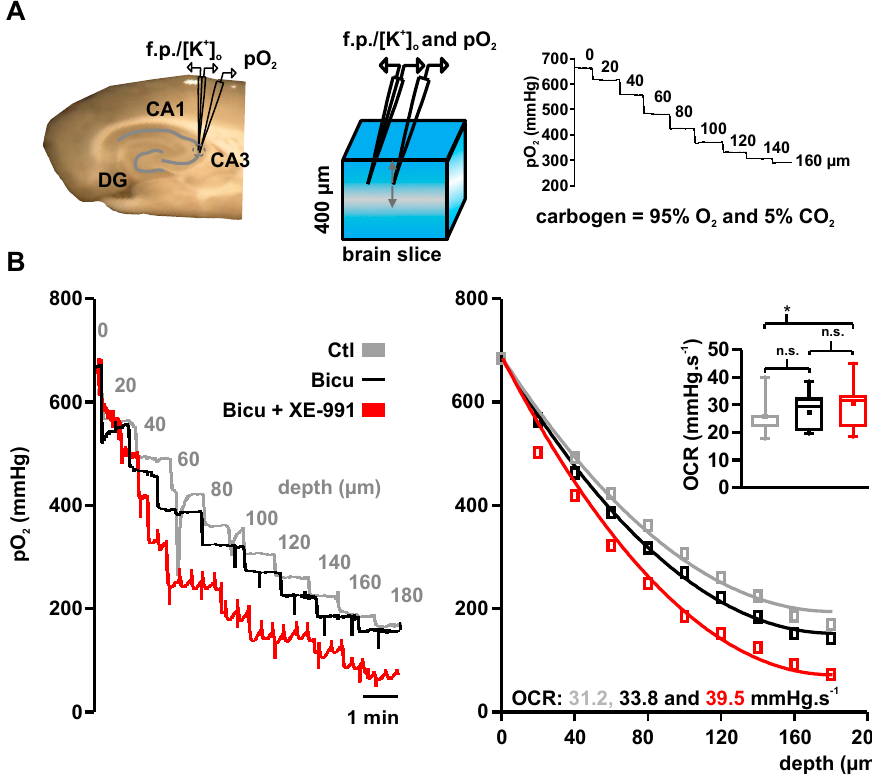
Figure 2. Variations in basal pO 2 under bicuculline and bicuculline + XE-991: ( A ) Left: Picture and scheme of typical electrode placement in acute hippocampal slice. Double-barreled ion-sensitive microelectrodes (with field potential and ion-sensitive recording side) and Clark-style oxygen electrodes were placed ~80 µ m below the slice surface in the pyramidal layer of area CA3. Acute brain slices receive oxygen from surface and bottom and the partial oxygen pressure (pO 2 ) decreases with the distance to the source of oxygen (i.e., distance to the slice bottom and surface) providing typical depth profiles (see right, numbers in trace—distance to slice surface). The oxygen gradient along the slice depends on oxygen supply and solubility, which are both constant under experimental conditions. Hence, changes in pO 2 depth profiles reflect activity-dependent O 2 consumption; and ( B ) Using an established reaction-diffusion model, peak pO 2 -levels at each vertical step in the pO 2 profile ( left ) were fitted ( right ) to calculate oxygen consumption rates (OCR). OCRs increased from control (spontaneous activity, gray , 31.2 mmHg · s − 1 ) to induced ILEs ( black , 33.8 mmHg · s − 1 ) and SLEs ( red , 39.5 mmHg · s − 1 ) in this example. The quantitative analysis (inset) revealed a significant OCR increase during SLEs ( red ) compared with control conditions ( gray , * p = 0.008, n.s. not significant, n = 8, paired t -test with Bonferroni post-hoc correction).